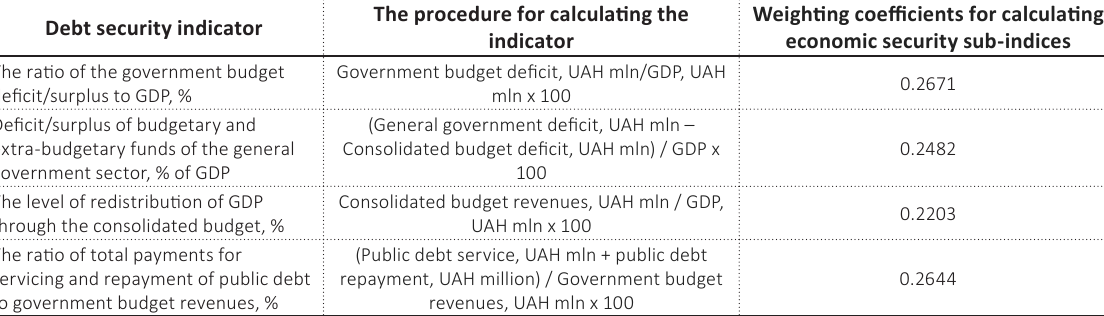
Table 1. List of indicators for calculating the integrated index of the country’s budget security and their weighing coefficients Source: Ministry for Development of Economy, Trade and Agriculture of Ukraine (2013).